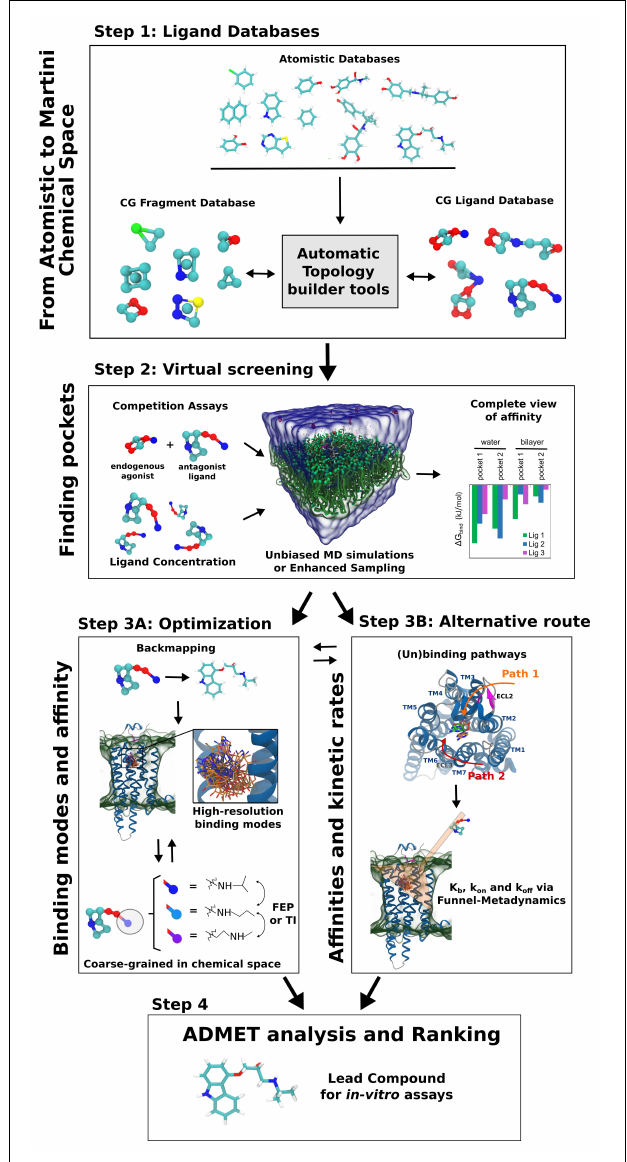
FIGURE 1 | One of the possible pipelines for high-throughput dynamic docking based on Martini coarse-grained modeling. (1) The first step in the pipeline is the automatic conversion of input libraries of small compounds to Martini models. The library includes drug-like compounds and small-sized rigid molecules, useful for fragment-based drug discovery. (2) In the second step, thousands of parallel simulations are automatically set up, to sample small-molecule binding to pockets in the target protein. Competition in silico assays with endogenous ligands are possible in this step. Performance can be straightforwardly increased by optimizing the ligand concentration as well as by employing enhanced sampling techniques. At the end, automatic analysis and ranking of ligands is performed, to obtain estimates of binding affinity in relation to different pockets and environments (e.g., binding to protein in relation to water and/or bilayer). (3A) After defining the pocket and a set of candidates, the accuracy of the prediction can be improved in third step: backmapping to the atomistic models can be performed, providing high-resolution details of the binding modes. Additionally, free energy perturbation (FEP) or thermodynamic integration (TI) estimating the energetic